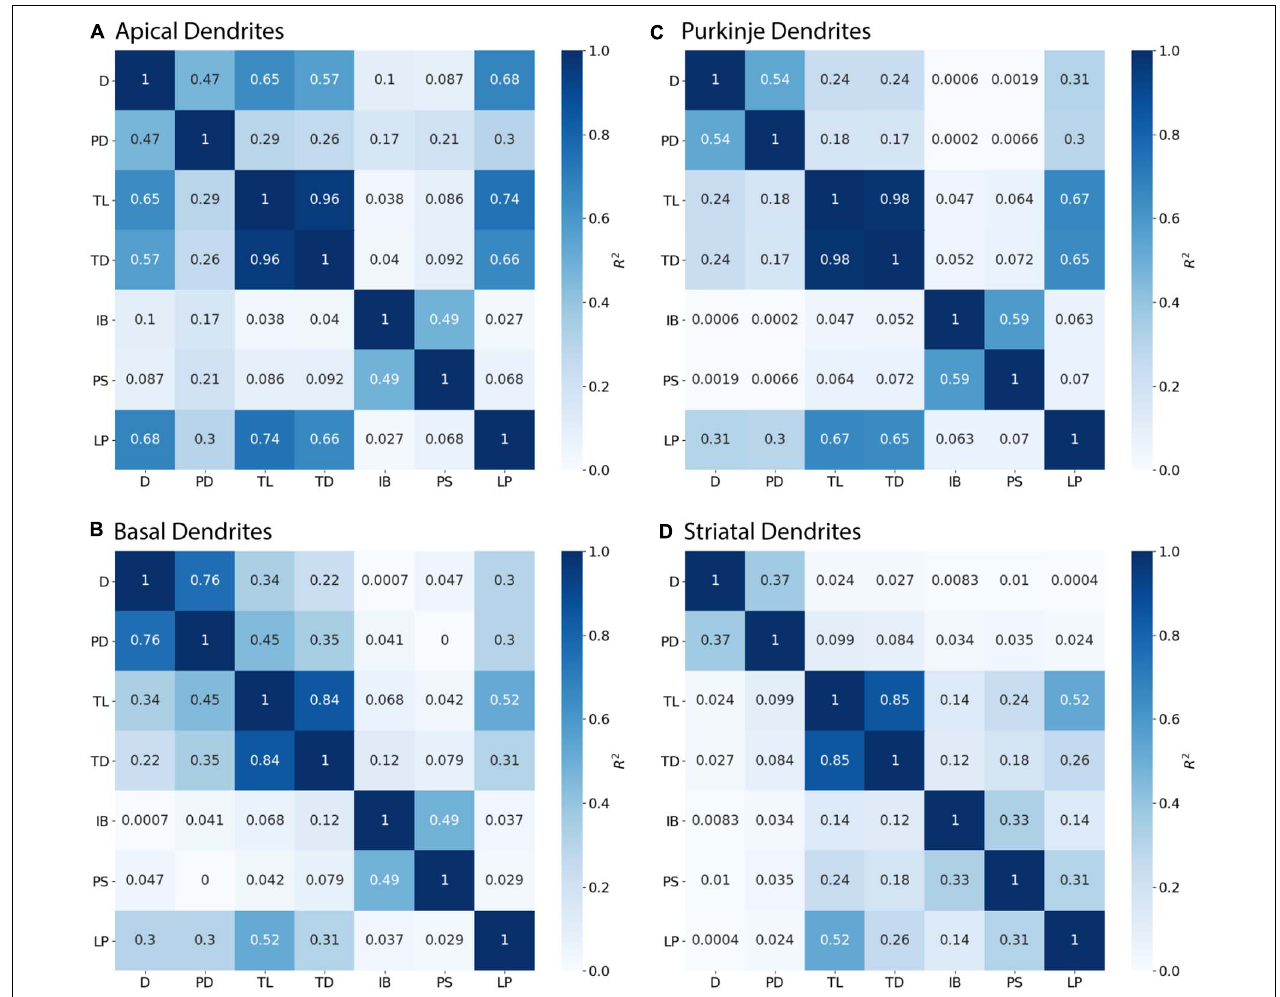
FIGURE 5 | Branching Children require Parent Diameter in combination with other features to predict diameter. R 2 as Pearson’s coefficient of determination. (A–D) Diameter of branching children have moderate to strong correlation with Parent Diameter (PD) across morphologies. Better model fits to diameter were obtained by adding select features with PD: Longest Path to Terminal End (LP) for apical dendrites of hippocampal pyramidal cells, Path to Soma (PS) for basal dendrites of hippocampal pyramidal cells, and Total Dendritic Length (TL) for cerebellar Purkinje